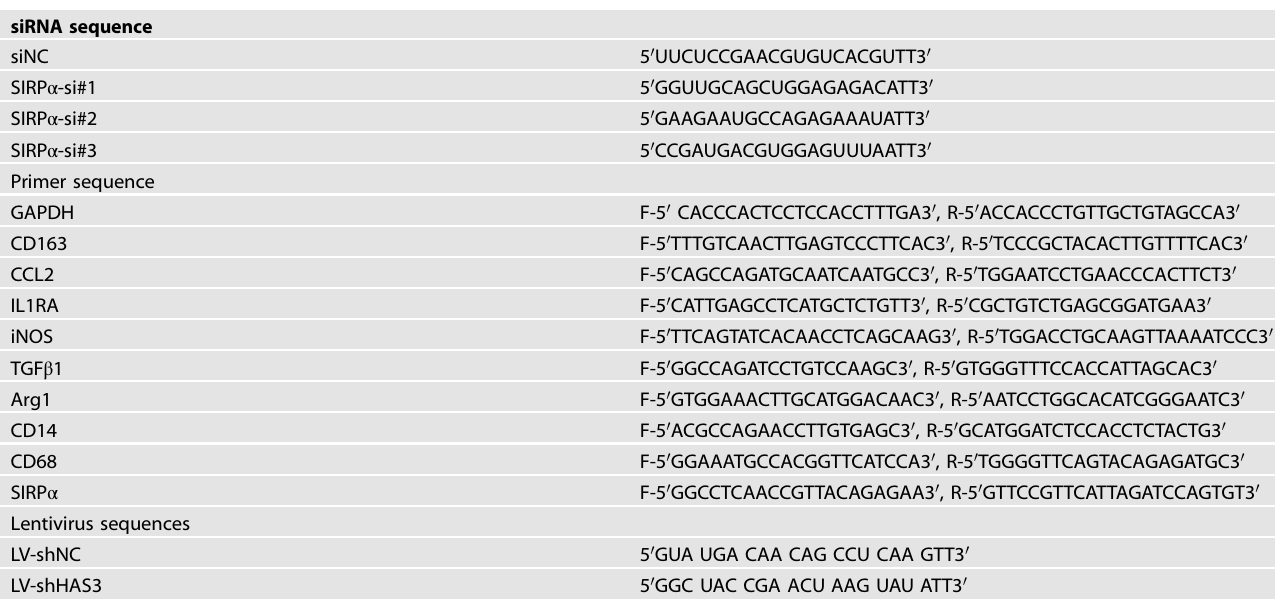
Table 1. Sequence of siRNA, primer, and